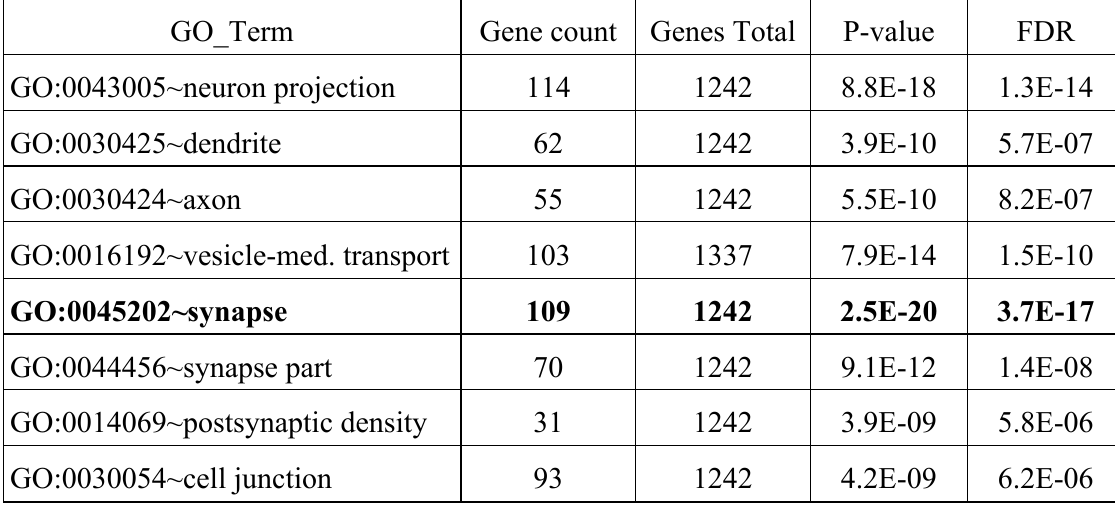
Table 2: DAVID GO neurospecific categories abundance elucidated in the gene